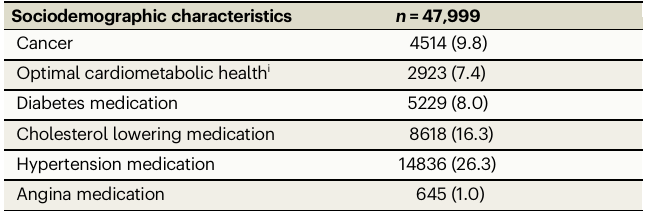
Table 1 | Baseline characteristics of the national sample of 47,999 U.S. adults in this investigation, 1999 – 2018 a Sociodemographic